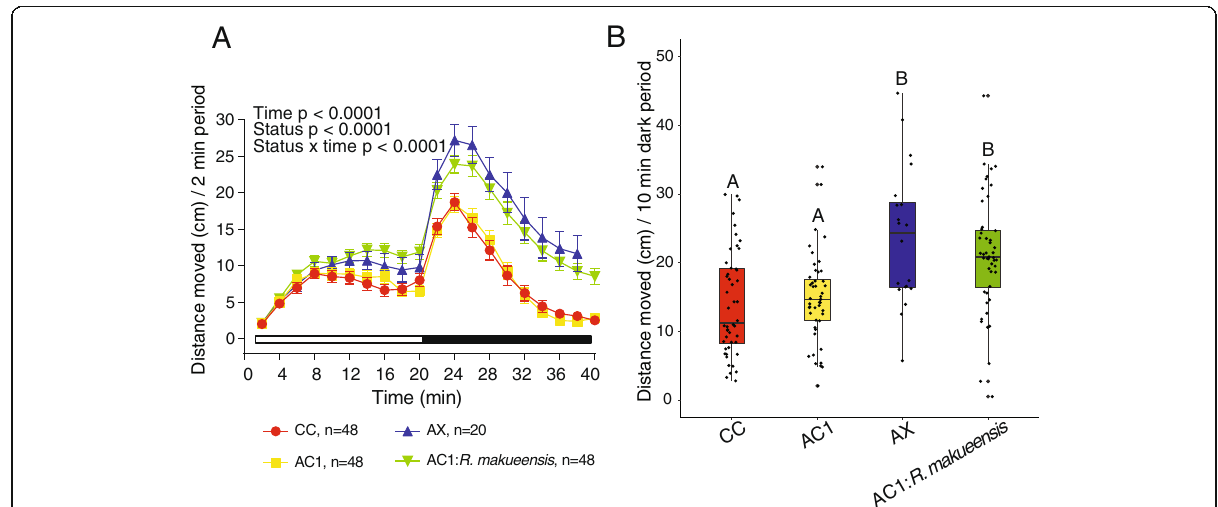
Fig. 5 Monoassociation with an environmentally-associated bacteria failed to block axenic-like hyperactivity. Distance moved every 2min in the light and dark periods ( a ; error bars =standard error of the mean) and mean distance moved every 10min in the dark period ( b ). CC=conventionally colonized; AC1=axenic colonized on day 1; AX